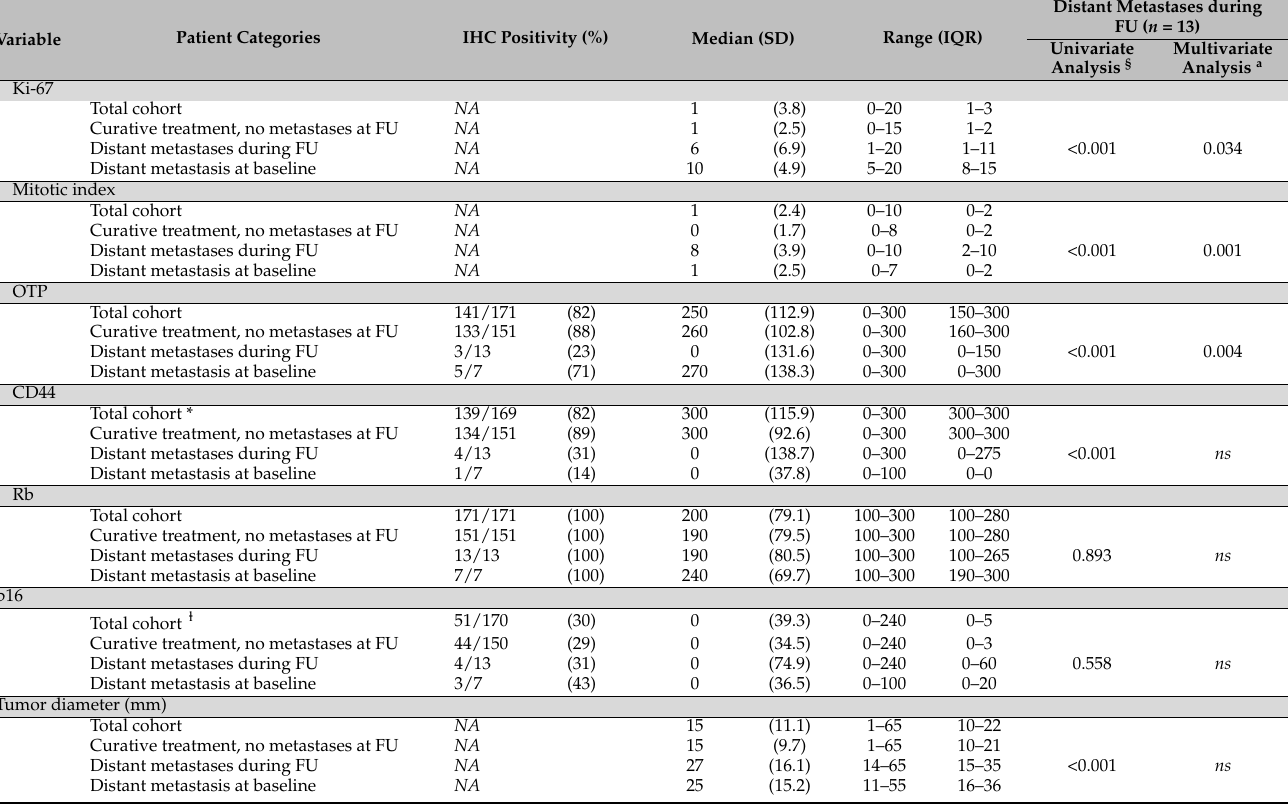
Table 2. Results of morphometric and immunohistochemical markers in different (prognostic) categories of bronchial carcinoid; significant p -values are reported in bold; curatively treated patients were selected as the reference group.